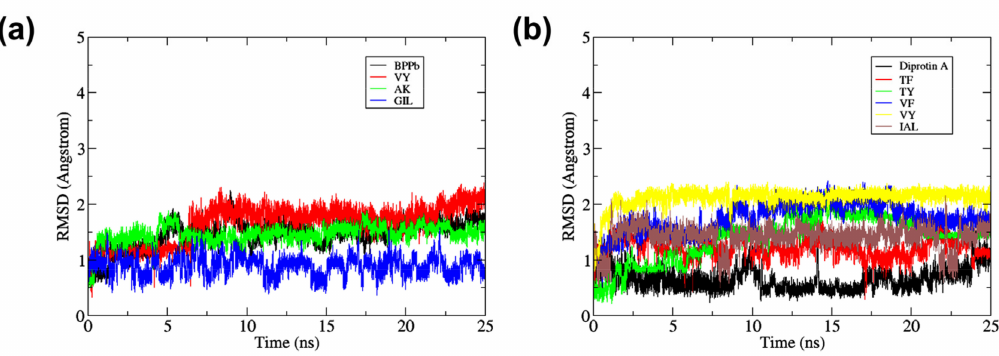
Figure 3. All-atom root mean square deviation (RMSD) of ( a ) ACE-docked peptide complexes ( b ) DPP-IV-docked peptide complexes during 25 ns of the molecular dynamics simulation.